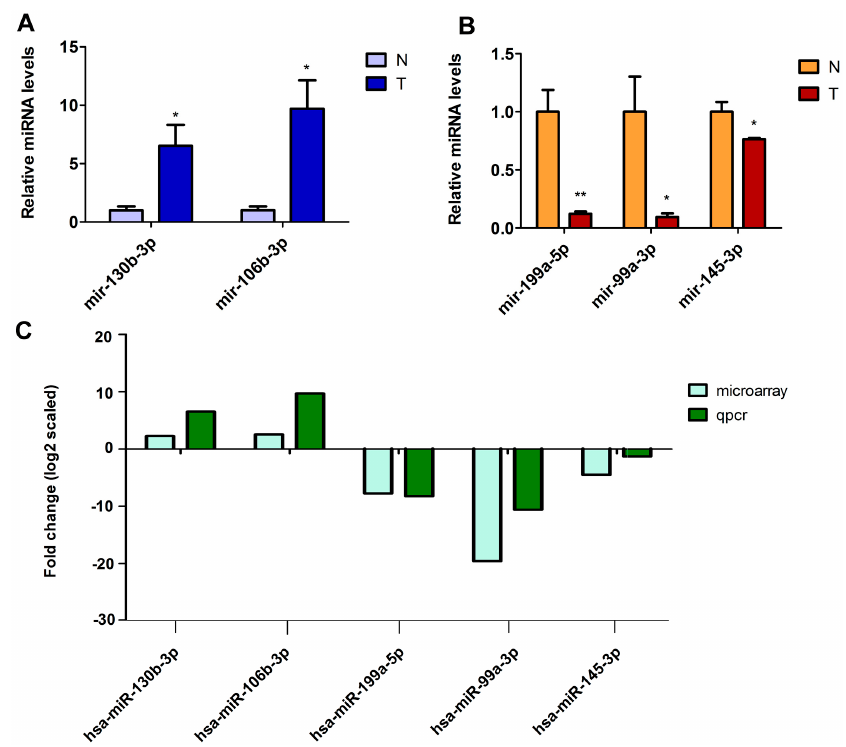
Figure 3. The differentially expressed miRNAs are validated in bladder carcinoma by quantitative RT-PCR. ( A , B ) The relative expression levels of the five miRNAs are shown in thirty pairs of tumor tissues (T) and normal tissues (N). Data are shown as mean ± SEM. * p < 0.05, ** p < 0.01, n = 30; and ( C ) The comparison between qPCR results and microarray data. The heights of the columns represent the fold changes (log2 transformed) computed from qPCR and microarray data respectively.